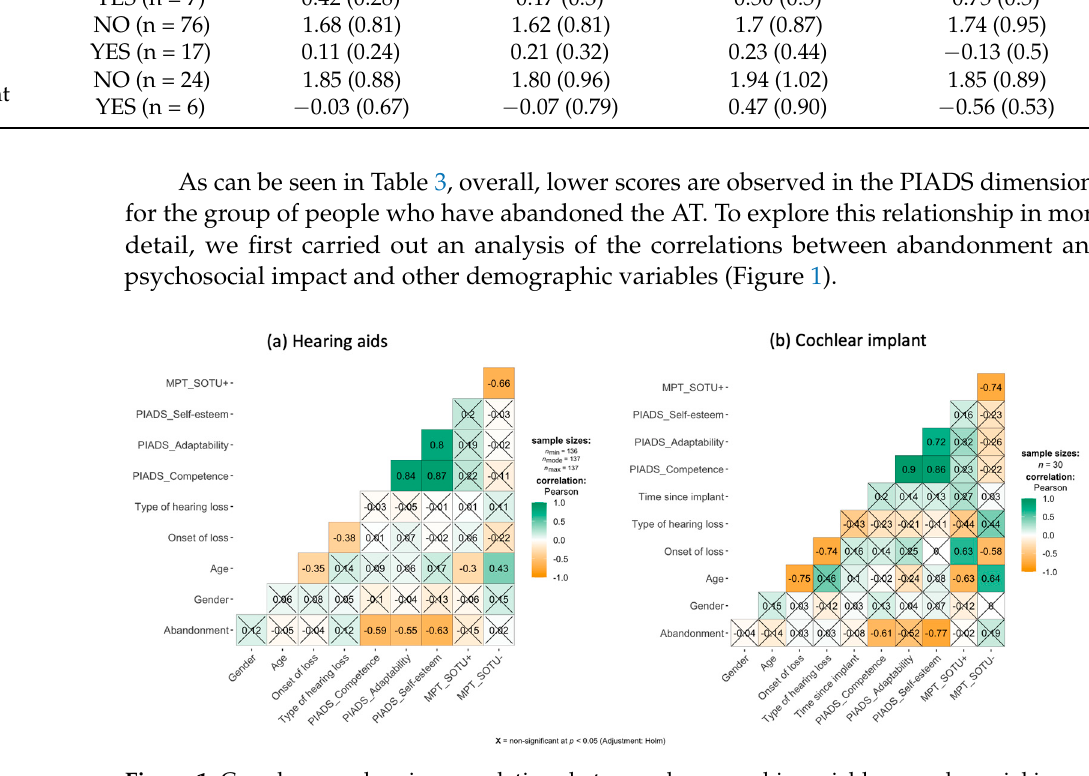
Figure 1. Correlogram showing correlations between demographic variables, psychosocial impact, positive and negative experiences with AT and abandonment for hearing aids ( a ) and cochlear implant ( b ). MPT_SOTU+ = Number of positive experiences with technologies; MPT_SOTU − = Number of negative experiences with